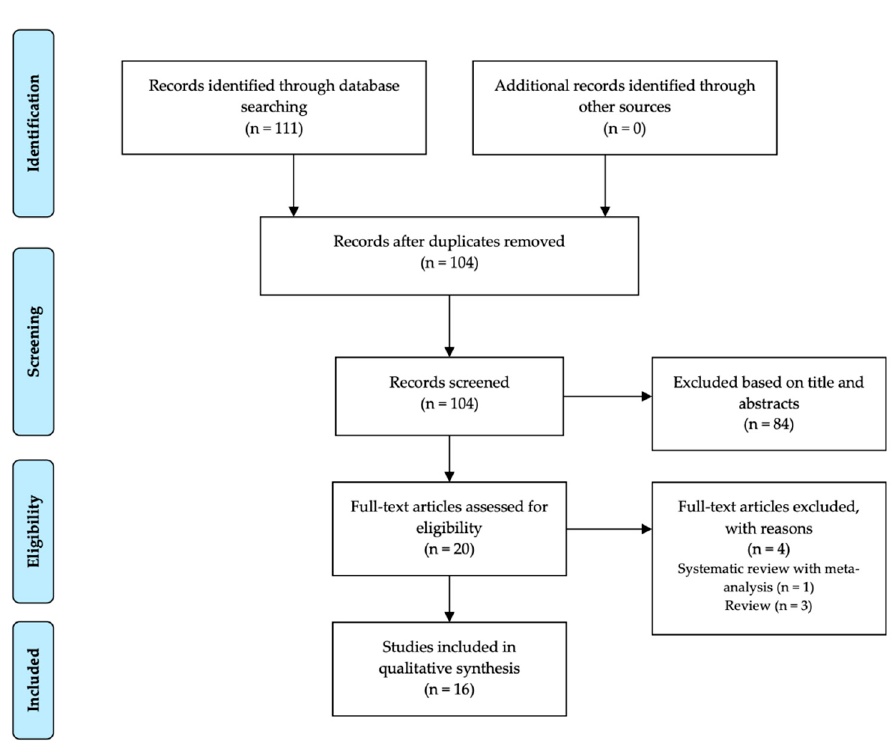
Figure 1. Process of literature screening.